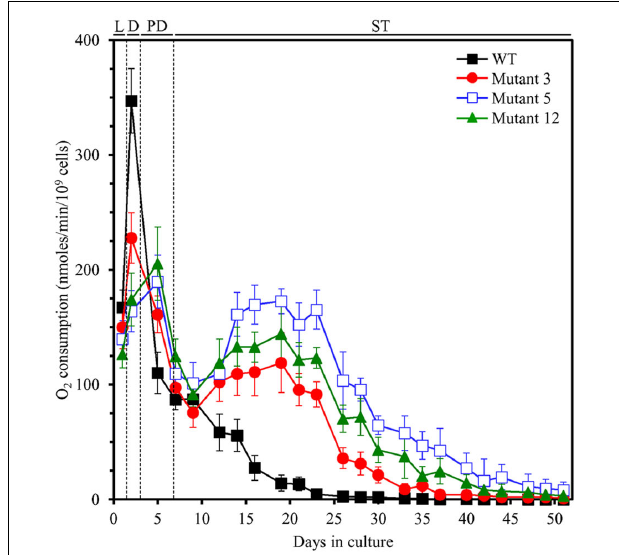
FIGURE 7 | Each of the three selected long-lived yeast mutants exhibits altered age-related chronology of mitochondrial respiration. The parental haploid WT strain and the long-lived mutant strains 3, 5, and 12 were cultured in YP medium without LCA initially containing 0.2% glucose. The dynamics of age-dependent changes in the rate of oxygen consumption by chronologically aging yeast is shown. Data are presented as means ± SEM ( n = 3). D, diauxic growth phase; L, logarithmic growth phase; PD, post-diauxic growth phase; ST, stationary growth